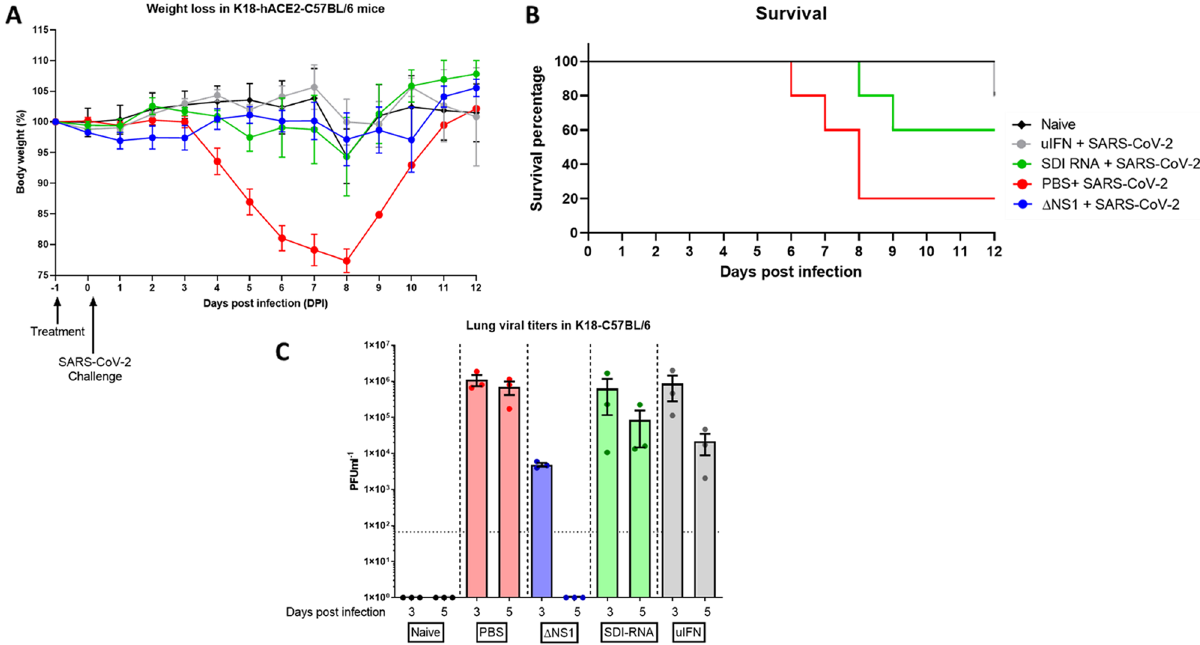
Figure 6. Treatment with ΔNS1 influenza virus inhibits viral replication in the lungs of K18-hACE2 mice challenged with SARS-CoV-2. Mice were intranasally treated with 30 ul containing PBS, 2.5 × 10 6 PFU of ΔNS1, 1 μg defective interfering RNA from Sendai virus (SDI-RNA), 2.5 × 10 5 U of universal-interferon (uIFN) 24 h before intranasal challenge with 10 4 PFU of SARS-CoV-2/USA/WA1 isolate. ( A ) Weight-loss was monitored in mice (n = 11 for treated groups and n = 6 naïve) and ( B ) survival was monitored for 12 days. ( C ) Lungs were harvested at days three and five post infection (n = 3 per group per day) were homogenized and were titered in Vero-E6 cells using standard plaque